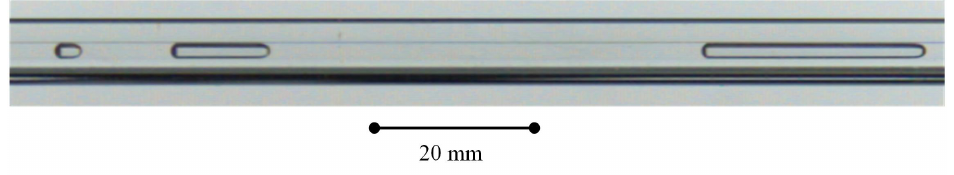
Figure 5. Plug-slug flow regime captured by high speed camera in the adiabatic section for the case of 100 W input power and ethanol as working fluid—52.6% filling